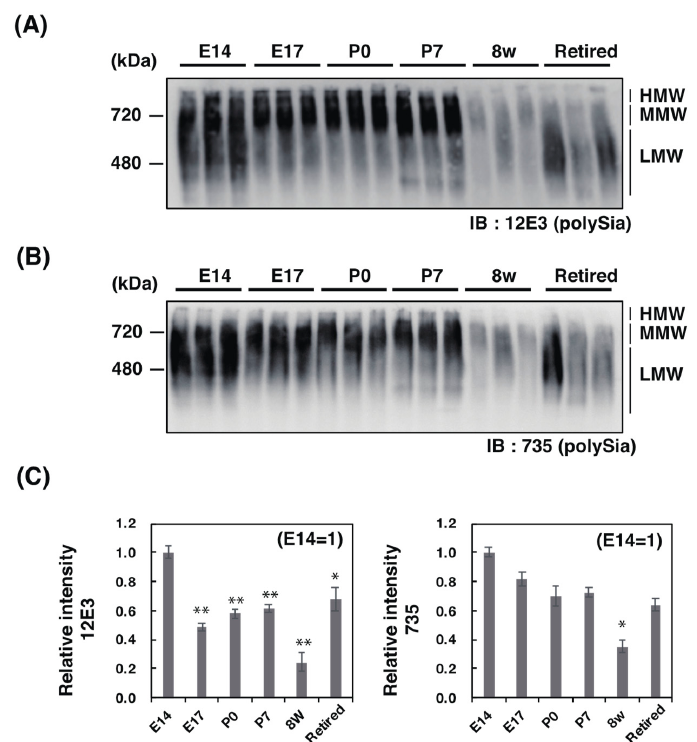
Figure 3. Native PAGE / Western blot analysis of polySia–NCAM derived from mouse brains at di ff erent developmental stages. PolySia expression at di ff erent brain development stages (E14, E17, P0, P7, 8 w, and retired, n = 3) were analyzed by native PAGE / Western blotting. The brain homogenates of six di ff erent stages were separated by native PAGE (7% polyacrylamide gel) and blotted onto polyvinylidene difluoride (PVDF) membrane (10 µ g as protein / lane). The polySia–NCAM was visualized by anti-polySia antibodies, ( A ) 12E3 and ( B ) 735. ( C ) The left panel shows the relative intensity of immunostaining of the 12E3 antibody. The right panel shows the relative intensity of the 735 antibody. E14 staining was set to 1.0. * p < 0.05. ** p < 0.01.